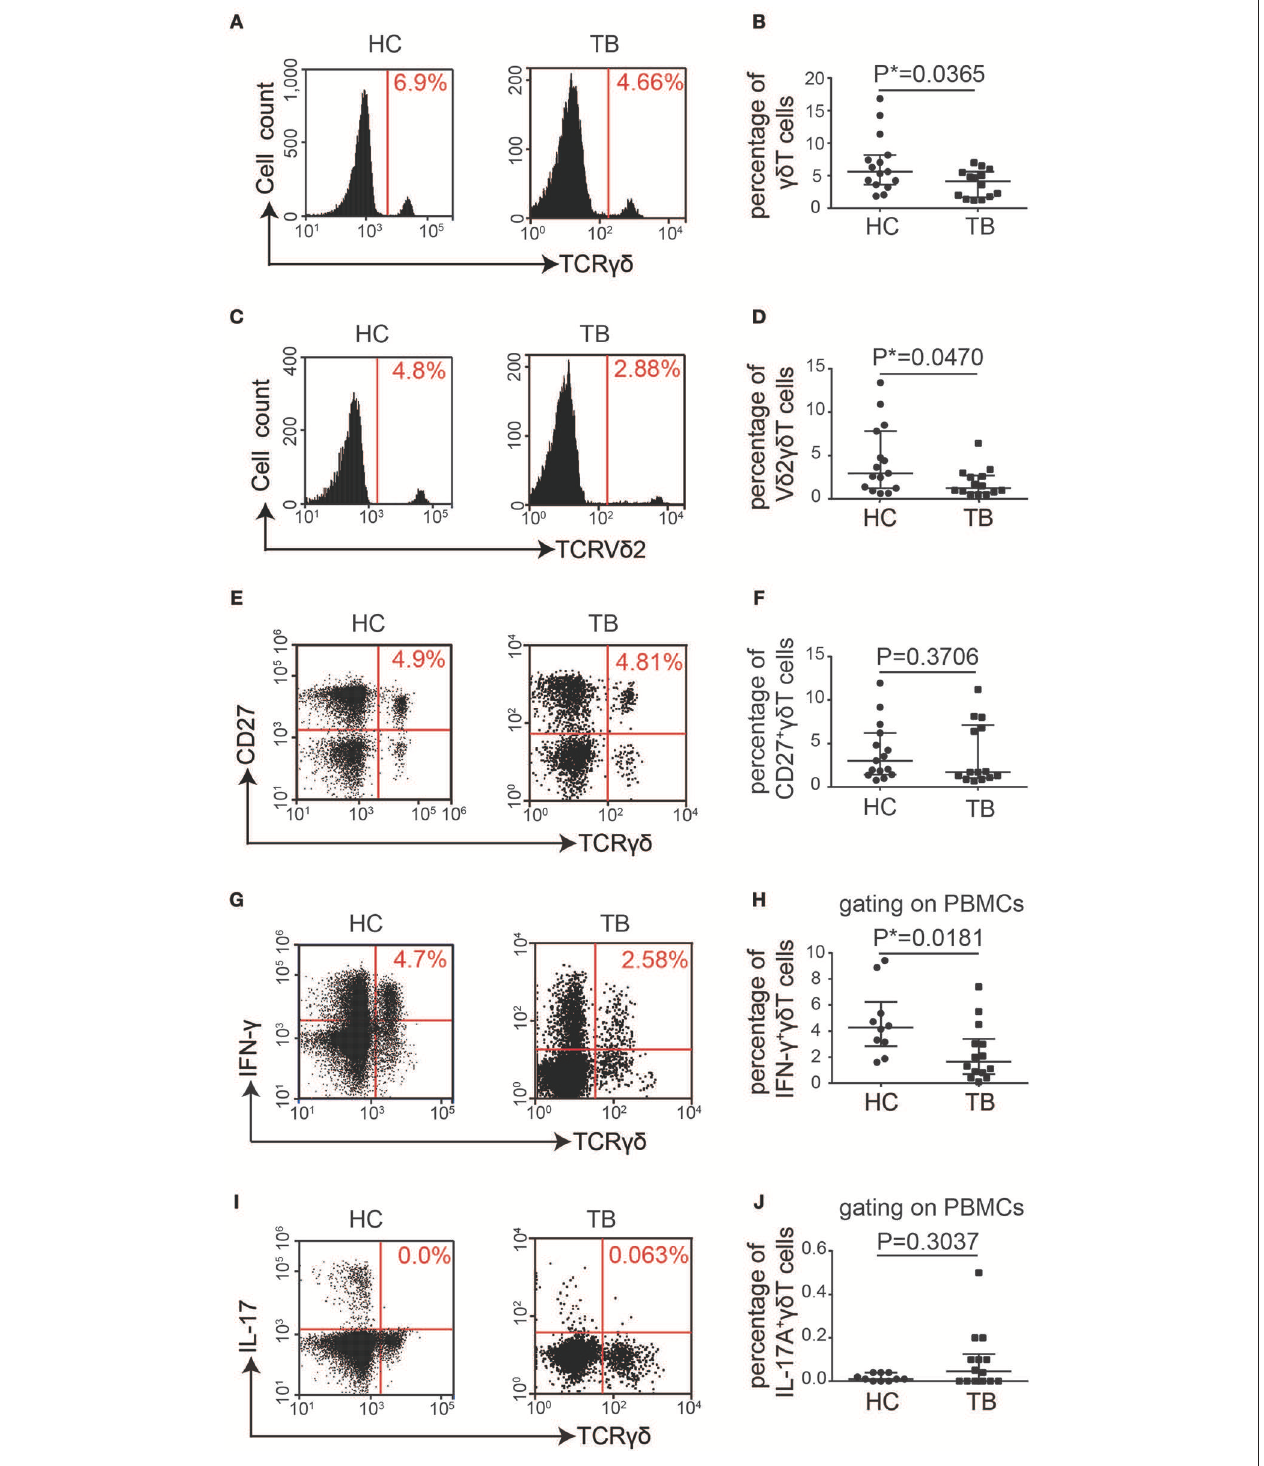
FIGURE 1 | The proportion of γδ T cells was significantly decreased in the PBMCs of TB patients. (A) Flow cytometry analysis of γδ T cells in PBMCs from healthy controls (HC) and TB patients (TB). (B) Quantification of the proportions of total γδ T cells from 15 controls and 14TB patients. (C,E,G,I) Flow cytometry analysis of V δ 2 γδ T cells (C) , CD27 + γδ T cells (E) , IFN- γ + γδ T cells (G) , and IL-17A + γδ T cells (I) in the PBMCs from 15 healthy controls and 14TB patients. (D,F,H,J) Quantification of the proportions of V δ 2 γδ T cells (D) , CD27 + γδ T cells (F) , IFN- γ + γδ T cells (H) , and IL-17A + γδ T cells (J) . Data represent the median with interquartile range. * P < 0.05 by two-tailed Mann-Whitney